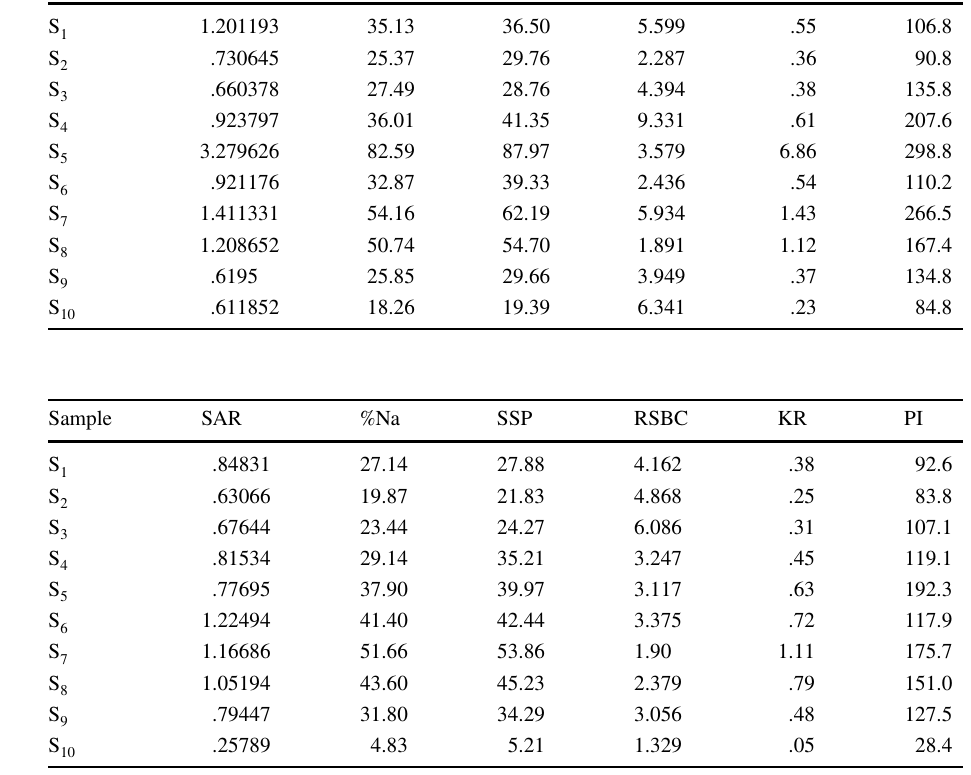
Table 8 Irrigation parameters during dry season